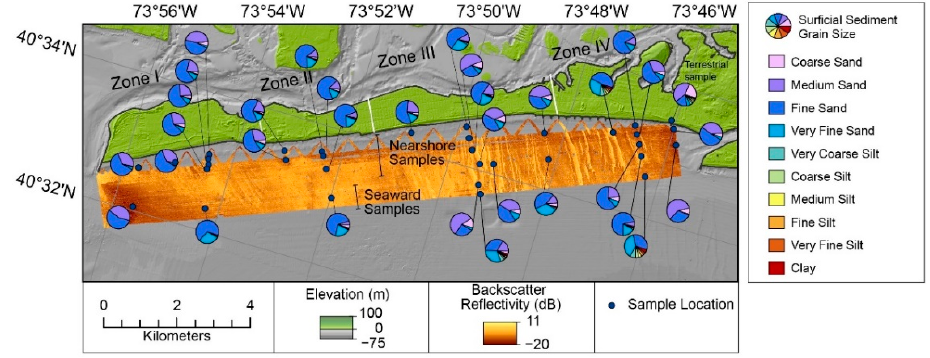
Figure 7. Grain size of surficial sediment samples are shown over the multibeam backscatter map. Locations of samples are shown by dark blue circles. Colors within the pie charts indicate the proportions of sand, silt, and clay.